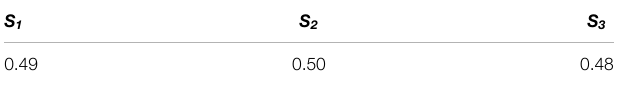
TABLE 5 | Inversion target value of relaxation evolution